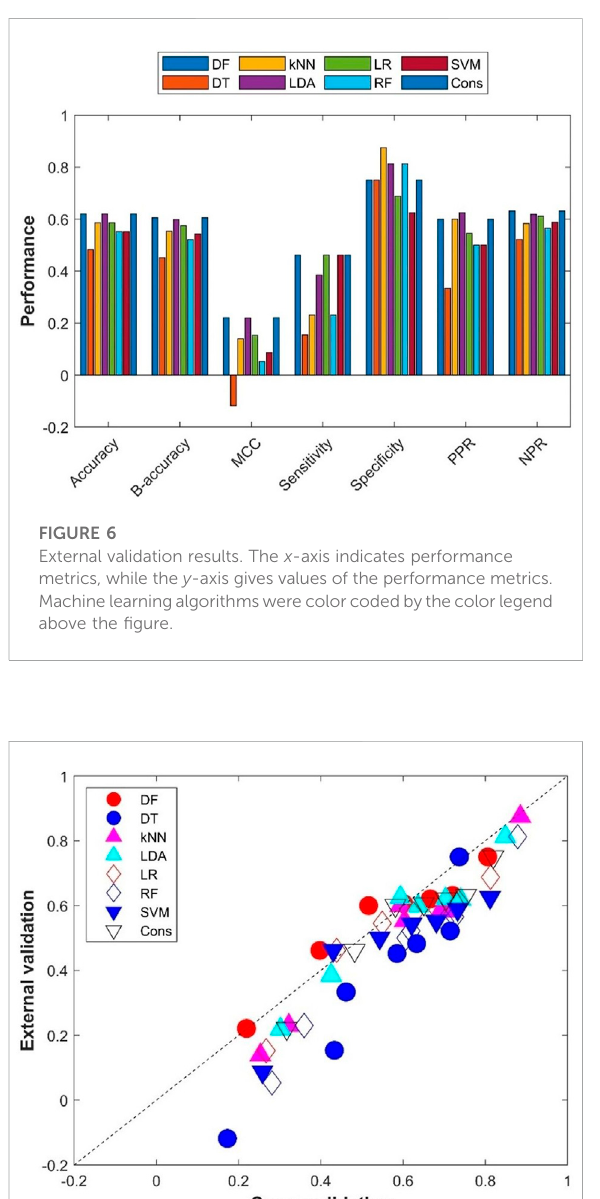
FIGURE 7 Performance metrics comparison between the cross- validations and external validations. The x -axis indicates the averageperformancemetricsfromthecross-validations,whilethe y -axis gives the values from the external validations. The diagonal dash line depicts where performance metrics are the same for the cross-validations and external validations. Results from the eight machine learning models are plotted in different shapes and colors given by the legend above the fi gure.